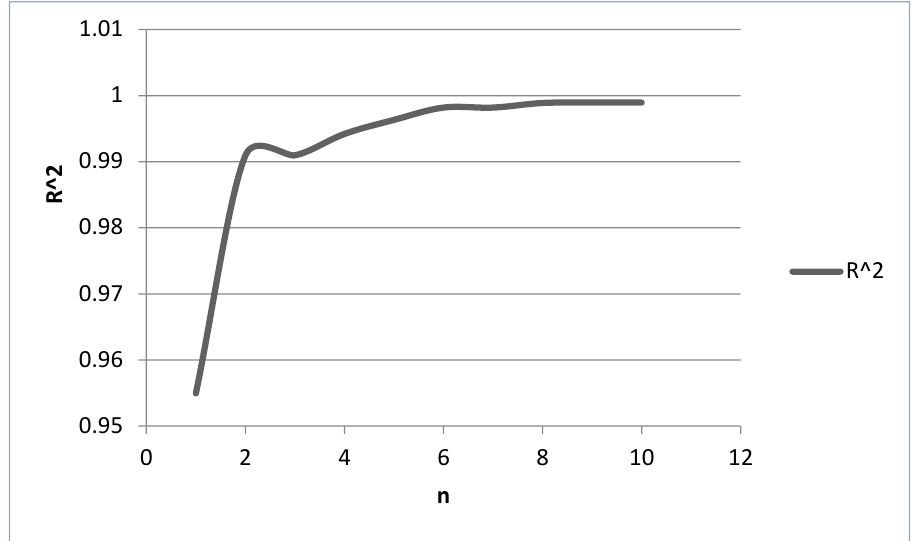
Figure 1. The relationship between the polynomial order ( n ) and the coefficient of determination R 2 according to the data of Table A2. Source: Authors’ calculations.